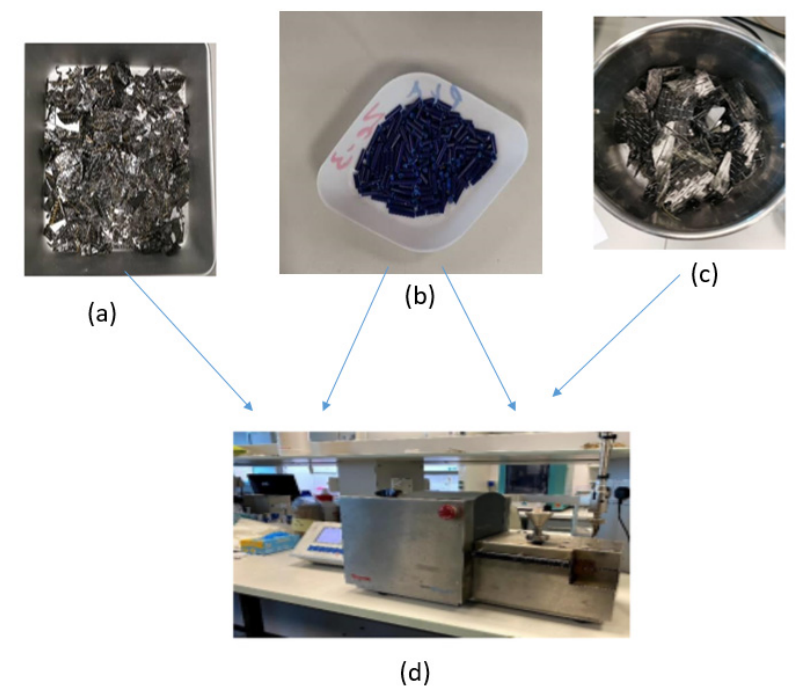
Figure 7. Samples of ( a ) CFRP, ( b ) PLA, ( c ) CF, ( d ) twin-screw extruder.